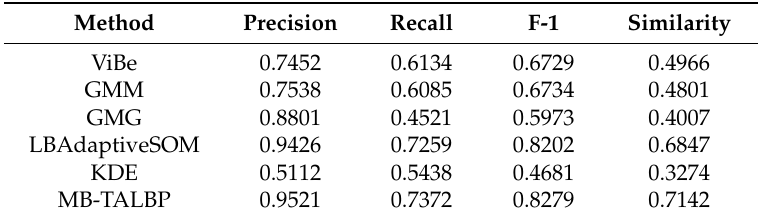
Table 1. Comparison of indexes of “Wandering students”.